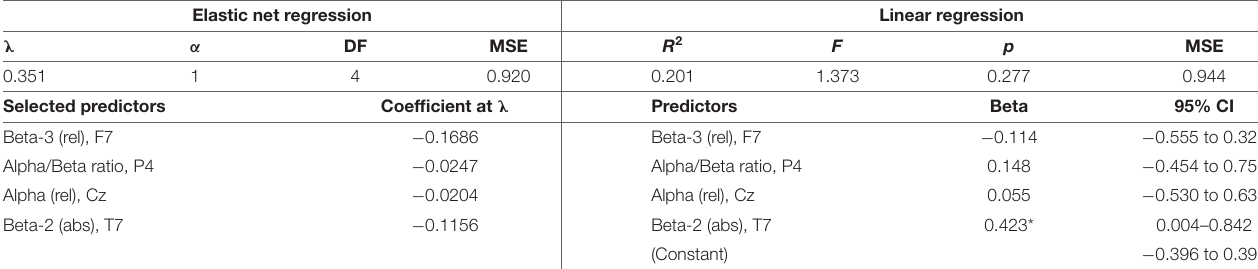
TABLE 4 | Regressions on PCL-M.